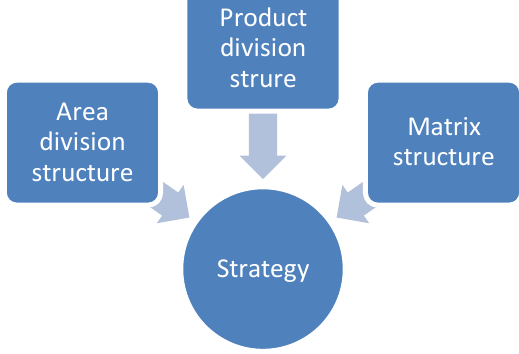
Figure 1: Conceptual